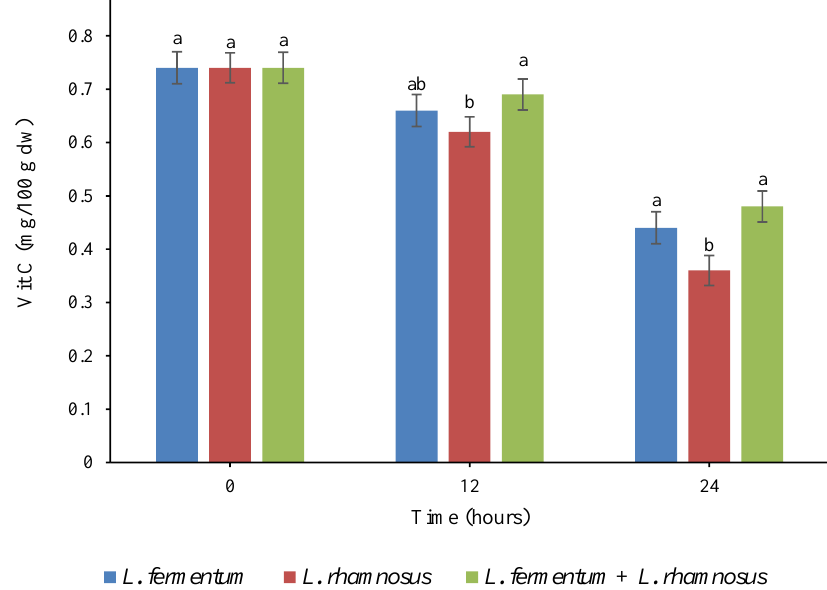
Figure 4. Changes in the vitamin C (mg/100 g dw) content in quinoa seed fermented by pure and binary mixed cultures of two Lactobacillus species. The error bars reveal the standard deviation of vitamin C in quinoa seed over 24 h of fermentation. The values with the same lowercase letters are not significantly different within the same fermentation hour ( p > 0.05). Red column: Lacticaseibacillus rhamnosus monoculture; blue column: Limosilactobacillus fermentum monoculture; green column: binary co-cultures of L. rhamnosus and L. fermentum.